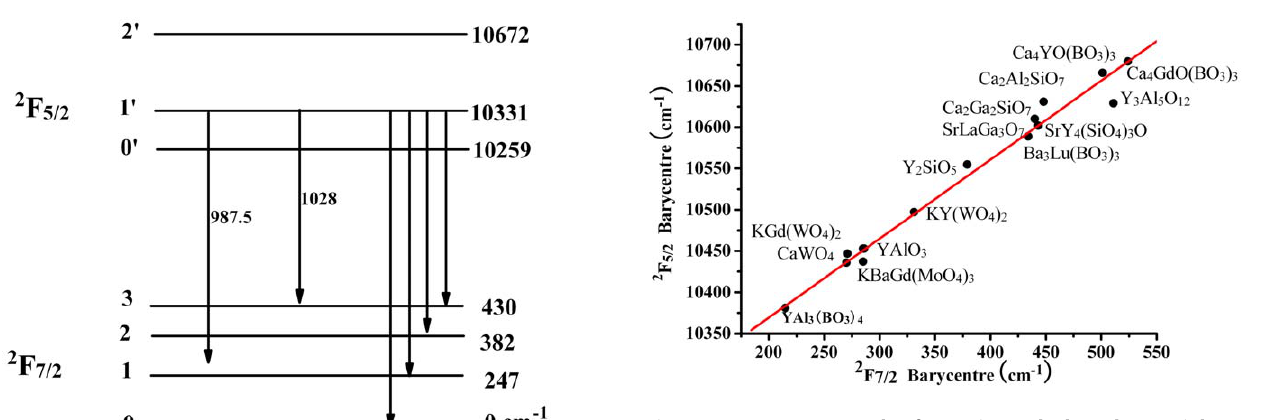
Figure 11. Barycentres plot for various Yb-doped materials.